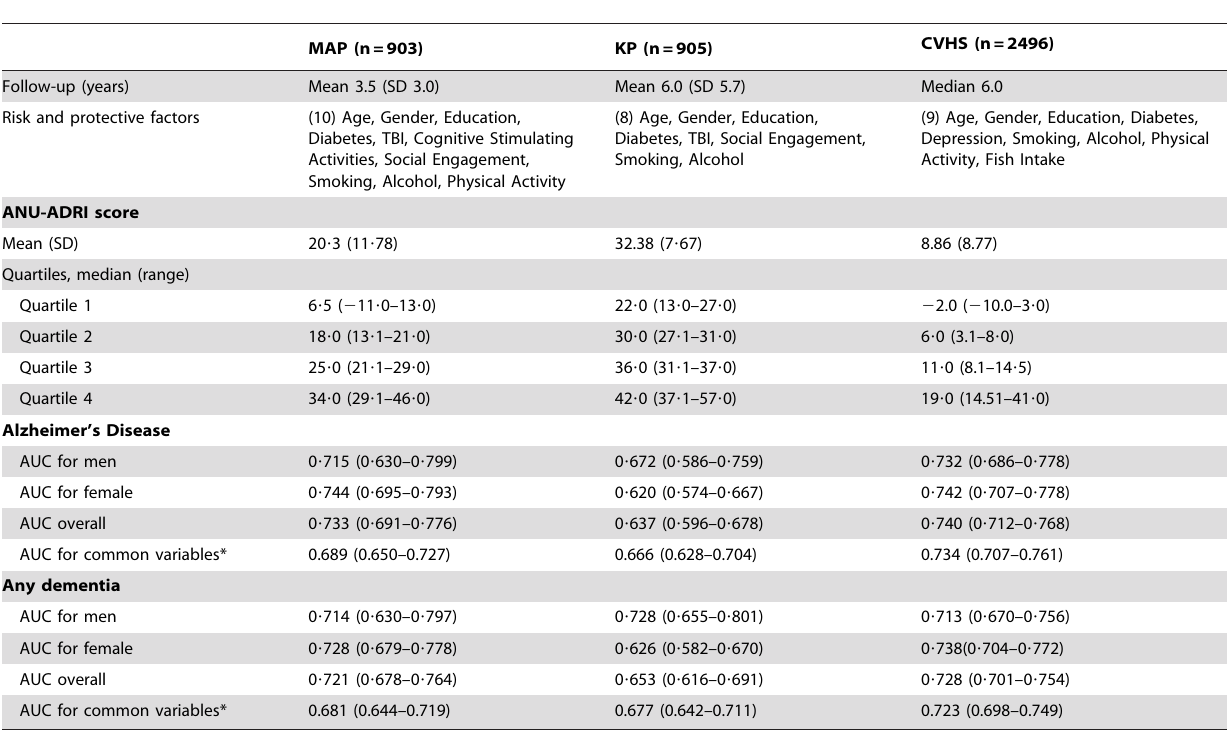
Table 3. Characteristics and accuracy of ANU-ADRI for predicting AD and dementia in the three cohort studies.